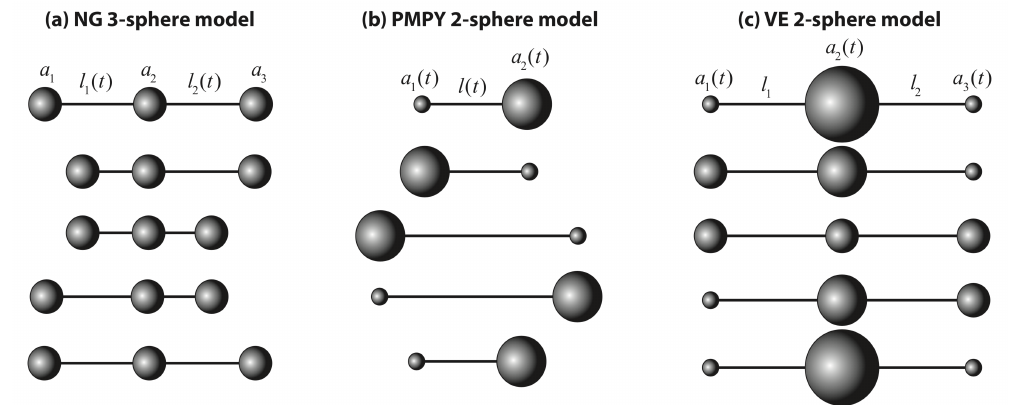
Figure 1. Linked-sphere LRN swimmers. ( a ) a NG 3-sphere model [10–12]. ( b ) a PMPY 2-sphere model [15]. ( c ) a VE 3-sphere model [17]. Figures show example strokes of each swimmer. Only shape deformations are presented, net translation of the swimmer is not